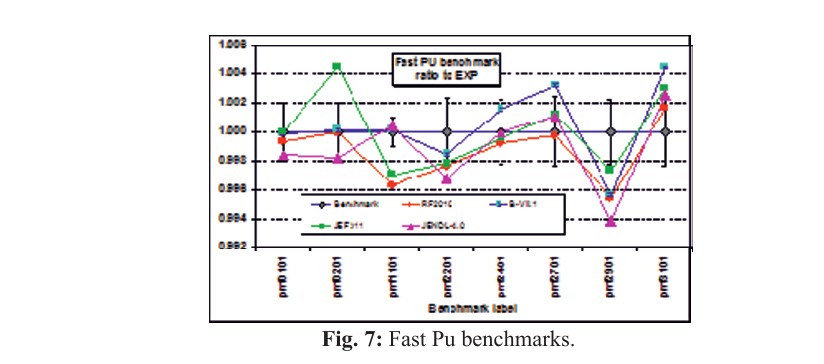
Fig. 6 : Fast HEU and LEU benchmarks.